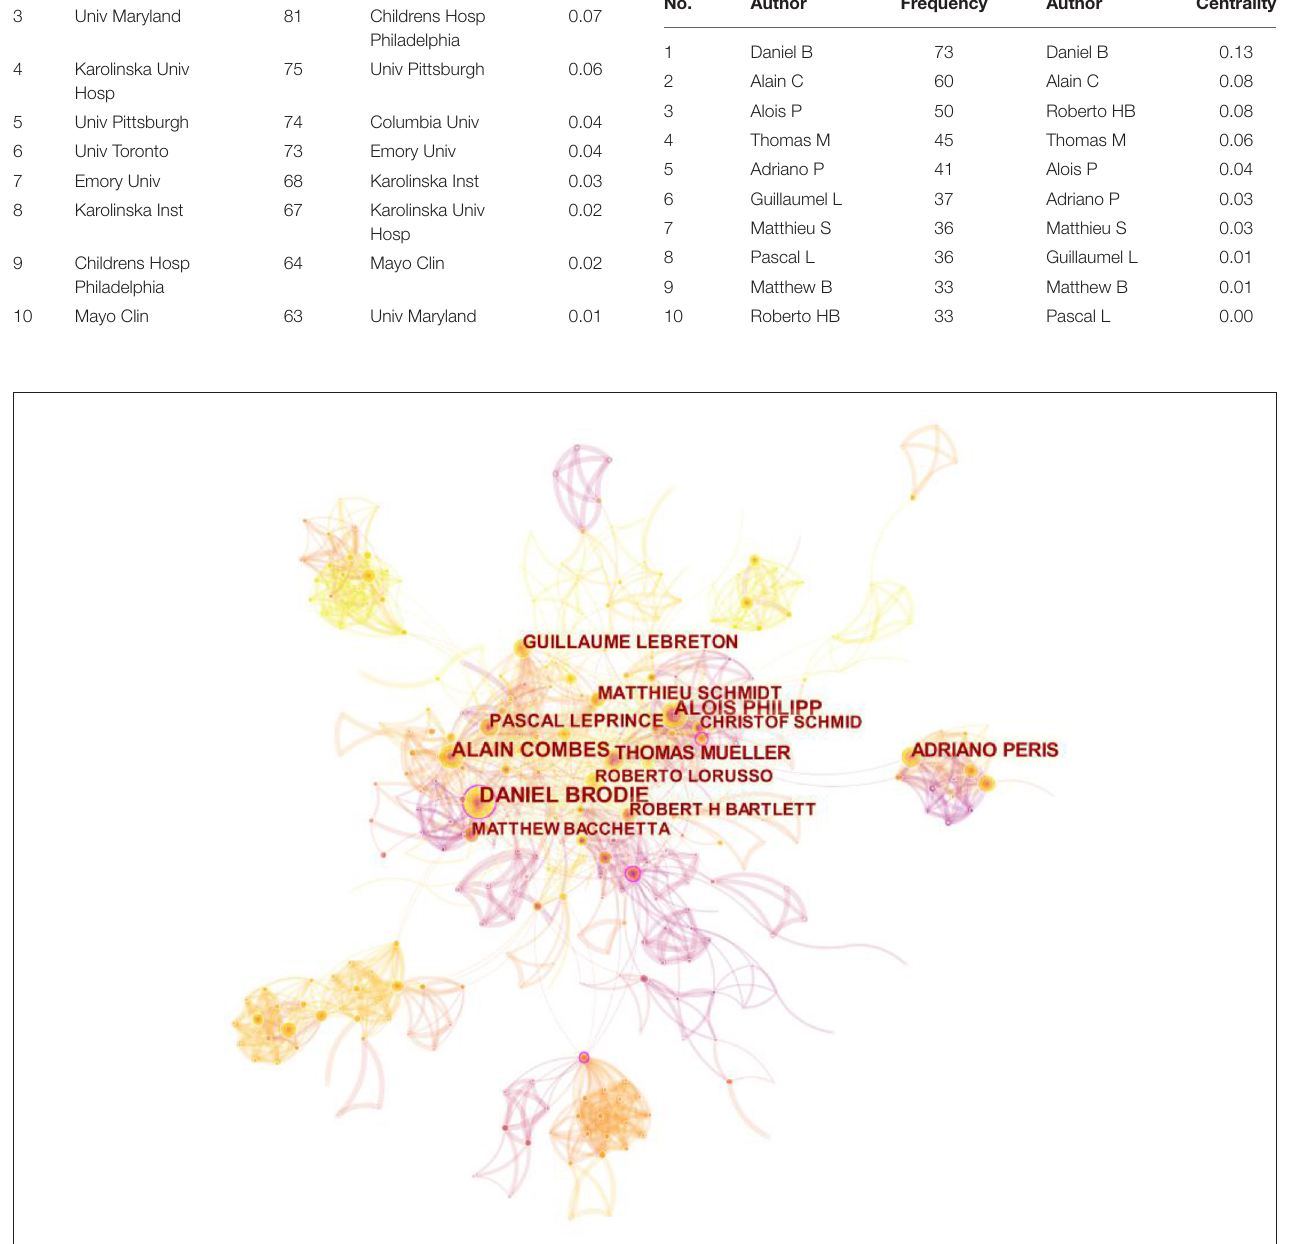
FIGURE 5 | Visualization map of authors.